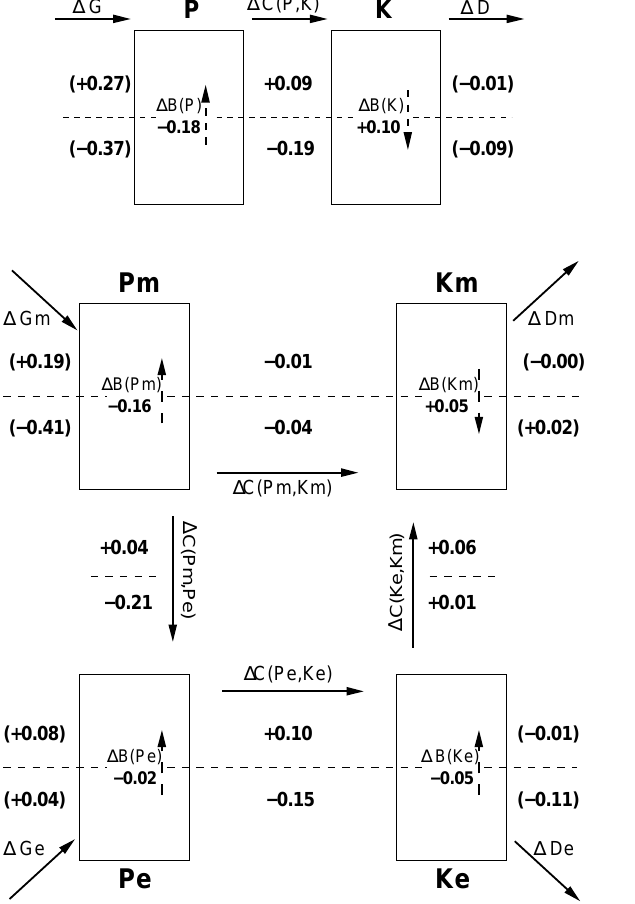
Fig. 4. 2-box (above) and 4-box (below) LEC diagrams of the changes in energy generation, conversion and dissipation rates due to CO 2 doubling. Units are Wm − 2 . Arrows indicate the direction corresponding to positive values; negative values imply opposite di- rection.